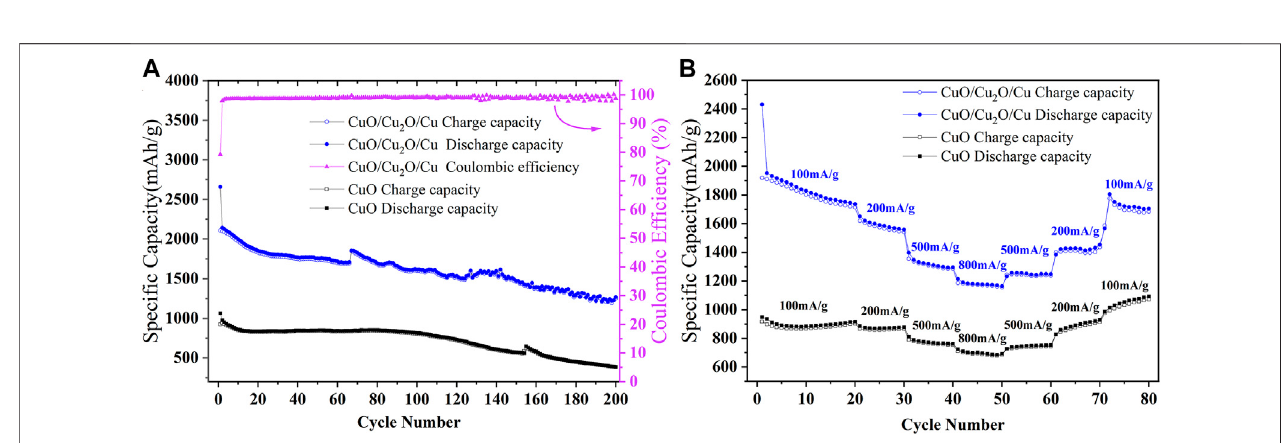
FIGURE 4 | The cycle stability (A) at a current density of 200 mA/g and rate capability (B) at different current densities of CuO nanowires and CuO/Cu 2 O/Cu nanocomposites.